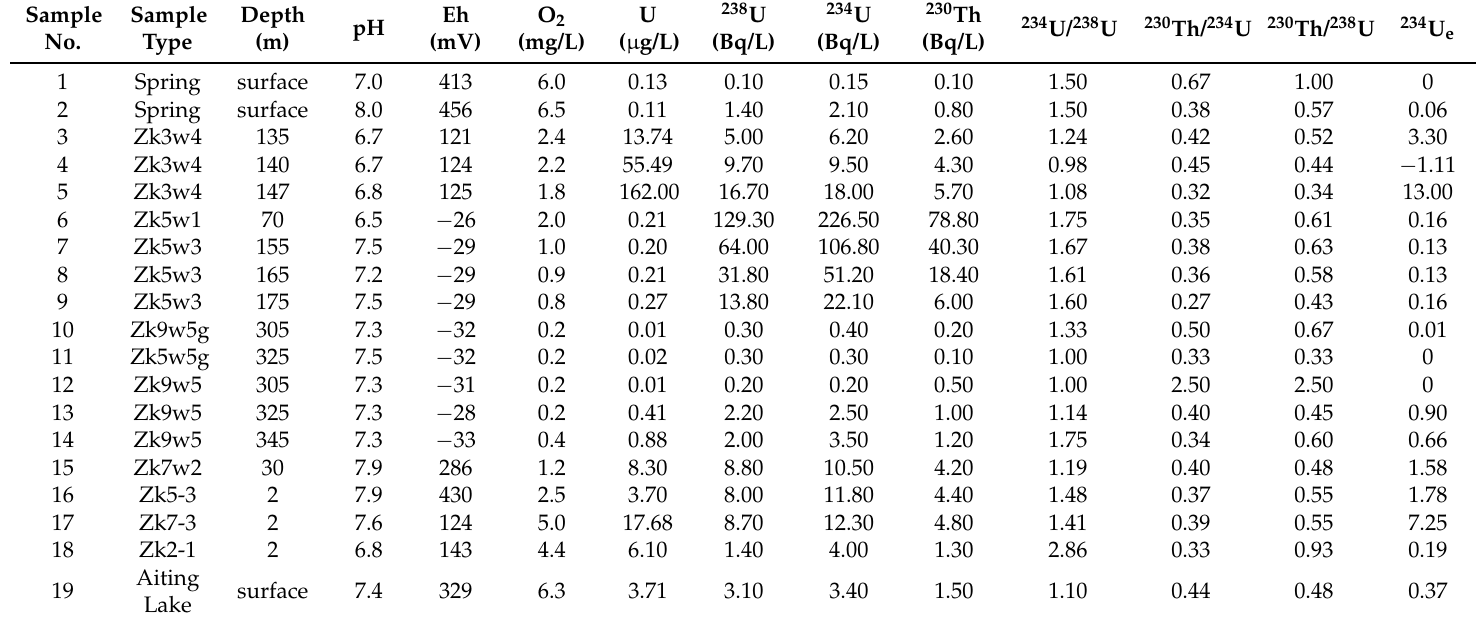
Table 1. Concentration and activity ratio of U-series isotopes in the waters collected from the Shihongtan U ore district flow